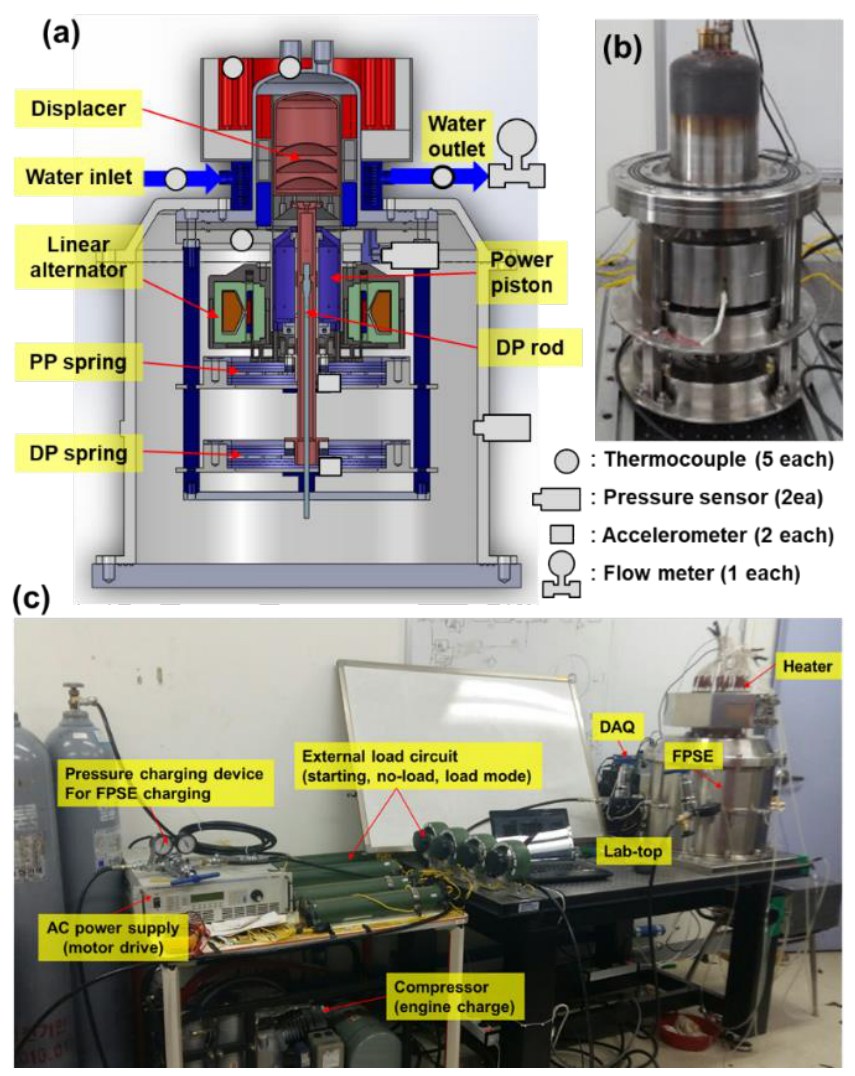
Figure 2. Test FPSE developed by the institute and its test rig: ( a ) cross-sectional drawing of the test FPSE with sensors, ( b ) manufactured FPSE inside casing, and ( c ) the test rig with an electric heater and an external electric load. Table 1. Dimensions and specifications of the test FPSE (working gas is air).